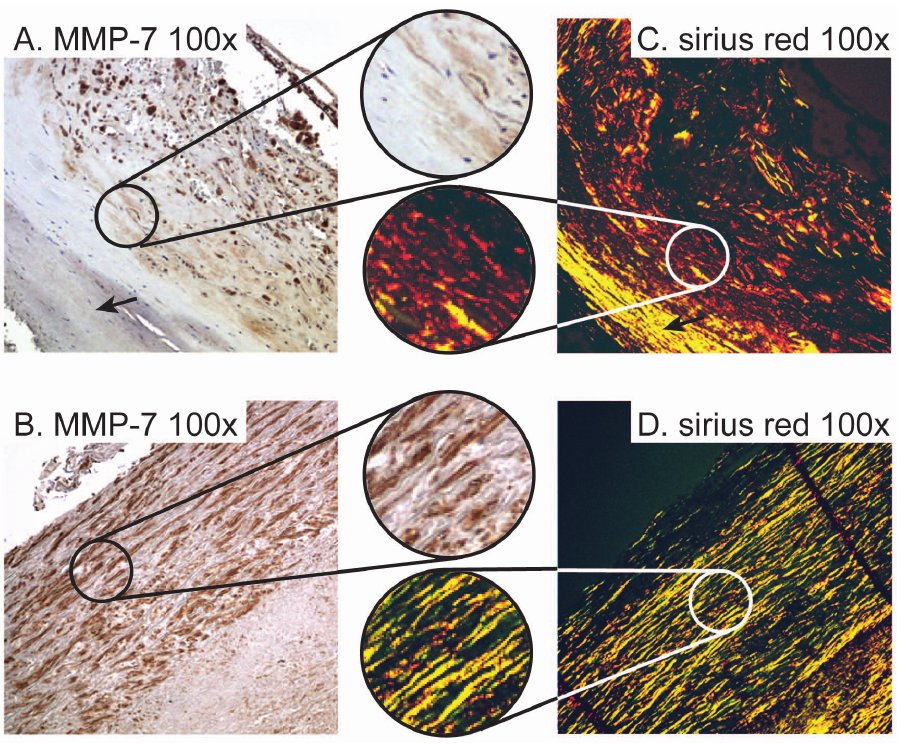
Figure 4. MMP7 staining in areas with thinner and less organized collagen fibers. Immunohistochemical staining of MMP7 in human atherosclerotic plaques at 100 6 magnification A and B. Sirius Red staining of collagen in corresponding sections of human atherosclerotic plaques are shown in C and D . The highlighted sections are from corresponding areas of sequential sections of the same plaques stained with MMP7 and Sirius Red, respectively, at 250 6 magnification. The arrows indicate area with no positive staining for MMP7 corresponding to areas with more organized and tightly packed collagen fibers.